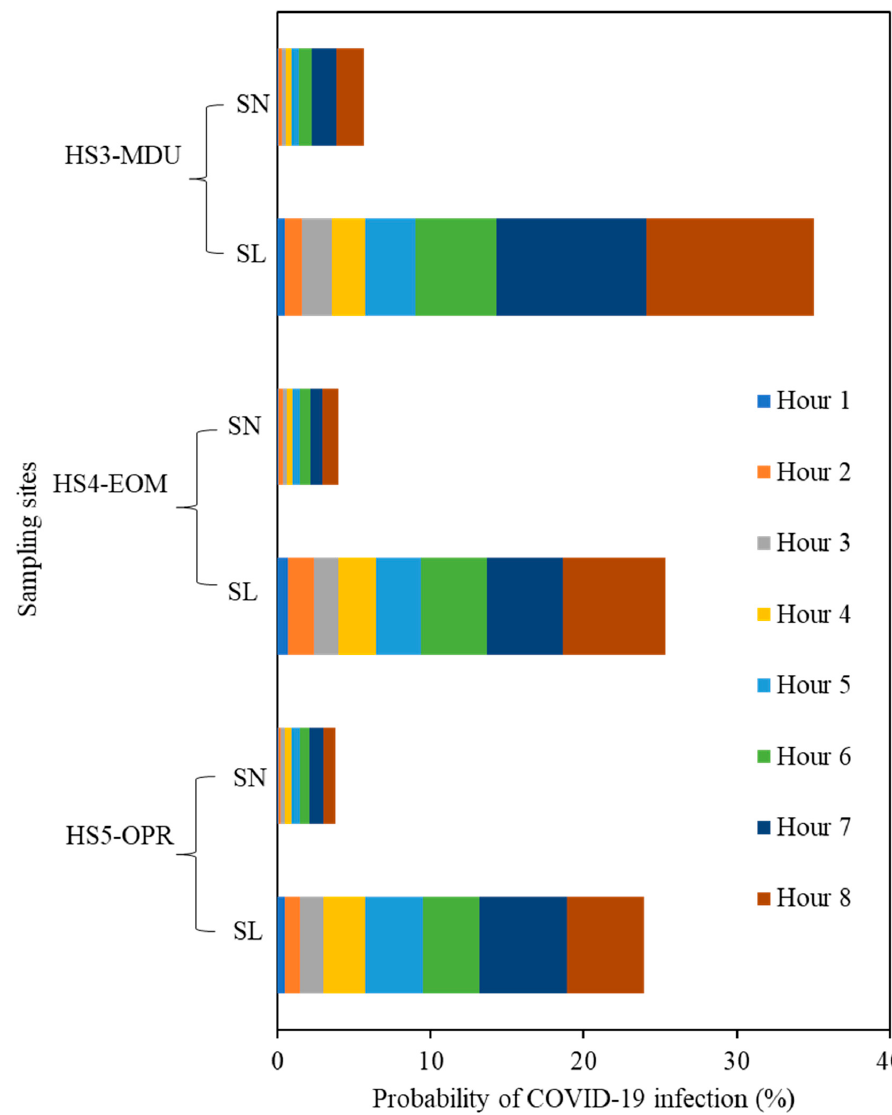
Figure 8. Probability of COVID-19 transmission (%) for the speaking loudly scenario (SL) and for the scenario of speaking normally (SN) where both infected/uninfected occupants wore face masks with 50% efficiency versus time.